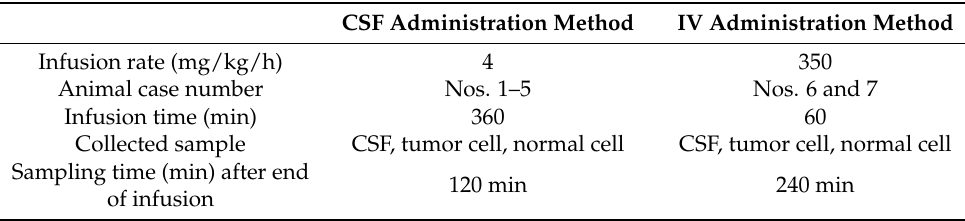
Table 2. Experimental conditions of boron uptake into brain cells by boron CSF administration method and IV administration method with BPA in melanoma model